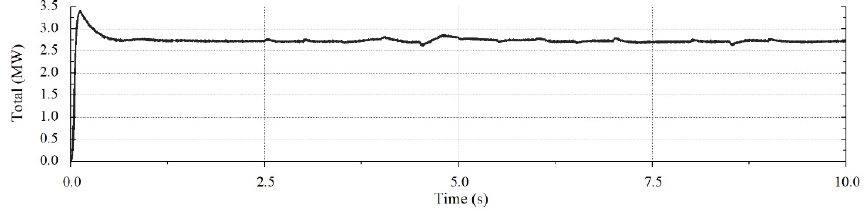
Figure 13. Quantity of power supplied from main grid (ESS-proposed control).